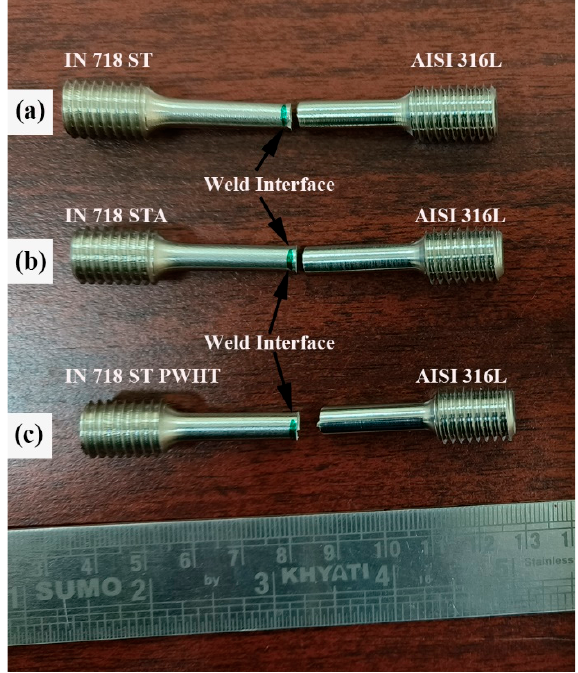
Figure 12. Tensile failure location of the dissimilar friction welds ( a ) AISI 316L-IN718 ST and ( b ) AISI 316L-IN718 STA and ( c ) PWHT.